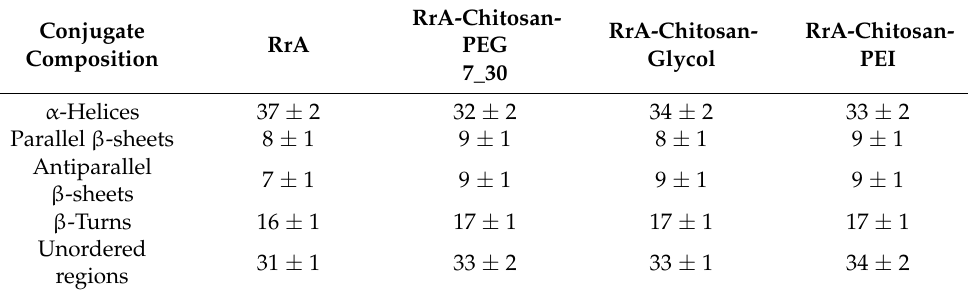
RrA-Chitosan- RrA-Chitosan- RrA-Chitosan- RrA PEG Glycol PEI 7_30